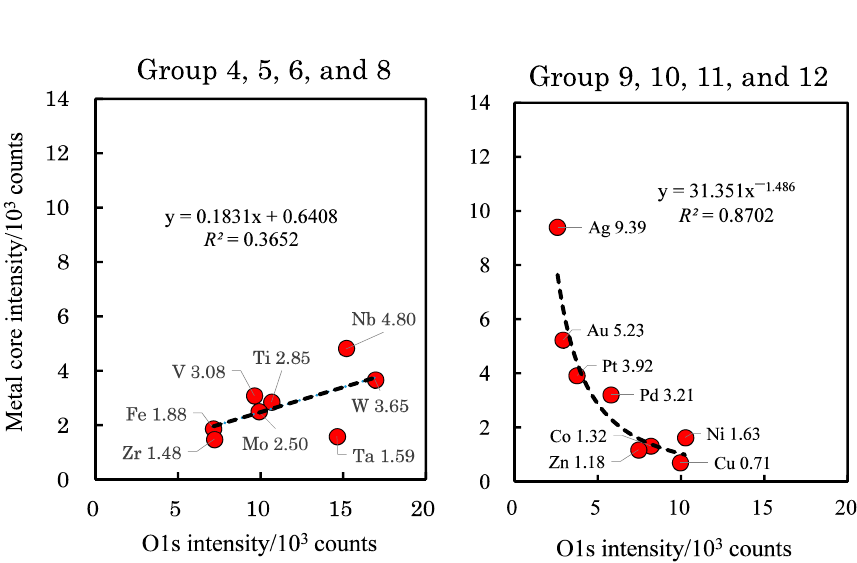
Figure 16. The plots of D(M–O) values for all metals used (above) and XPS intensities of metal core (below) for metals in groups 4, 5, 6, and 8 and in groups 9, 10, 11, and 12 against O1s intensities after TriboEE measurement.